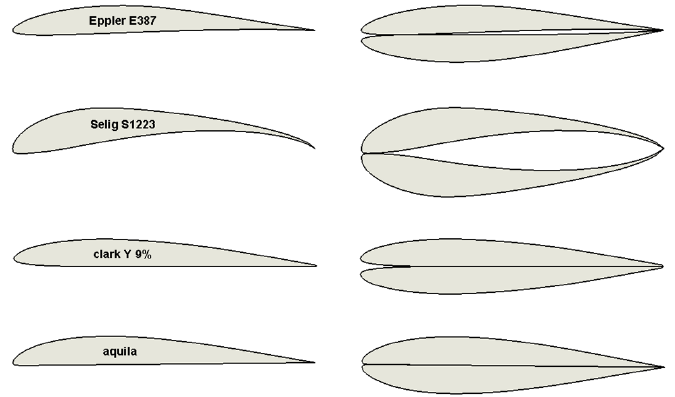
Figure 16. Airfoils samples, originally selected for glider aircraft ( left ) and their resulting aerobatic airfoil upon folding ( right